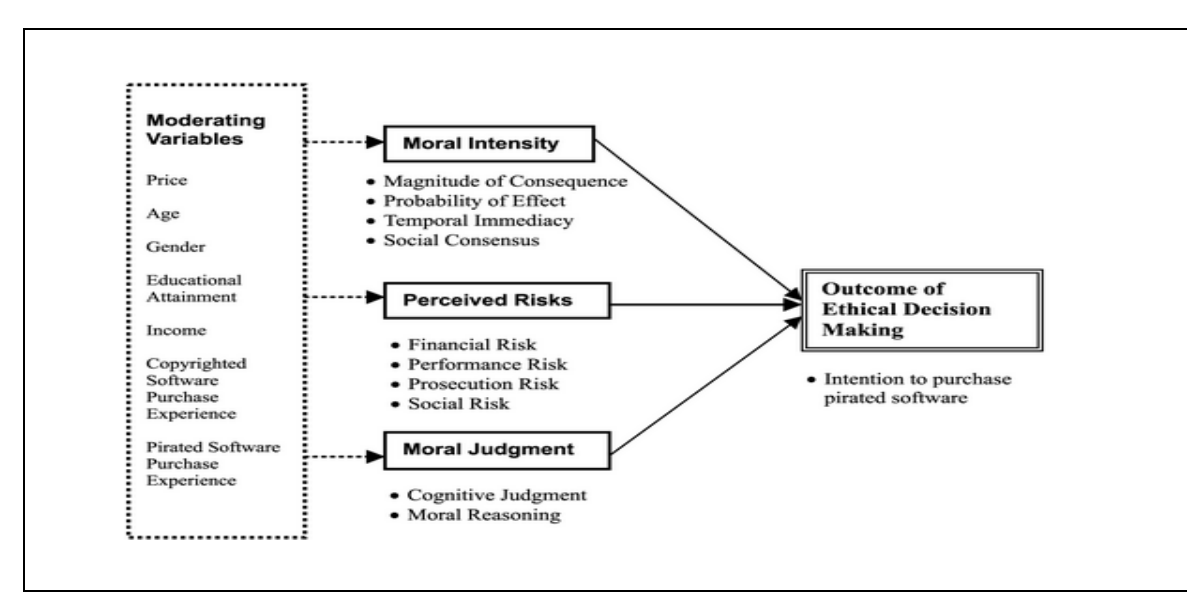
Issue-risk-judgement model (Tan,